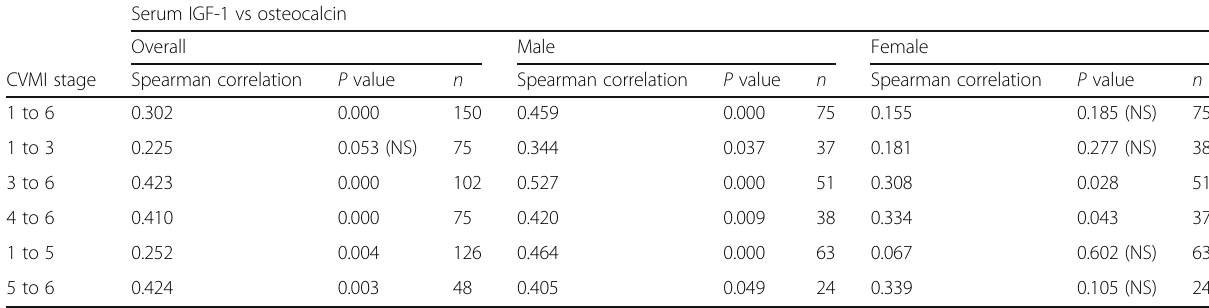
Table 5 Spearman coefficient of correlation between serum IGF-1 and osteocalcin for different CVMI stages Serum IGF-1 vs osteocalcin